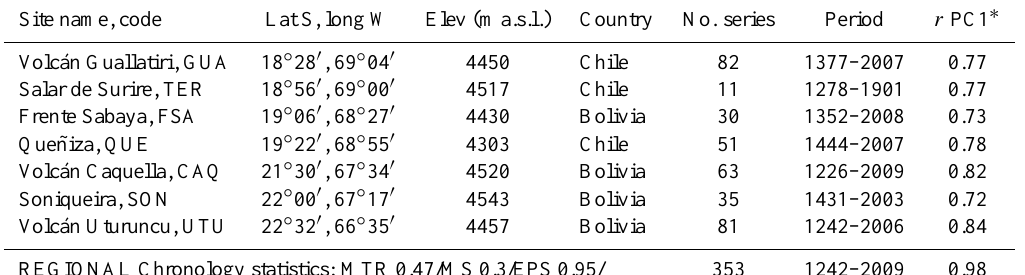
Table 2. Characteristics of Polylepis tarapacana tree-ring sites and the regional chronology from the Altiplano, Central Andes. Site name, code